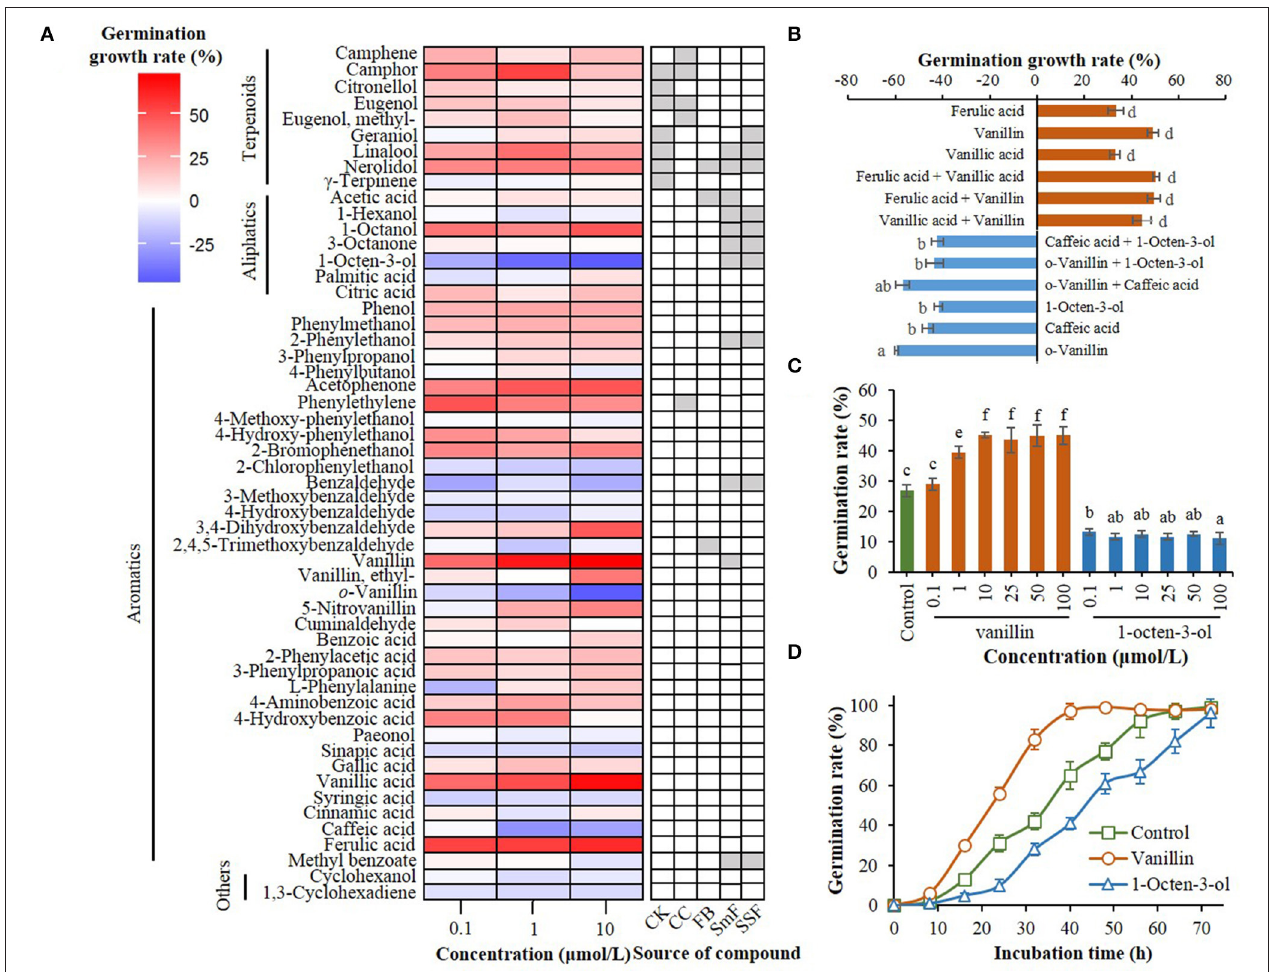
FIGURE 1 | Effect of compounds from C. kanehira , C. camphor , and A. camphorata as well as their analogs on the germination of A. camphorata arthroconidia. (A) Heatmap showing germination growth rate of the arthroconidia after 24h of incubation with candidate compounds in 96-well microplates. CK, Cinnamomum kanehirae ; CC, C. camphora ; FB, fruiting bodies of A. camphorata ; SmF, submerged fermentation of A. camphorata ; SSF, solid-state fermentation of A. camphorata ; (B) Effects of positive and negative regulators (10 µ mol/L) and their synergistic effects on the germination of arthroconidia after 24h of incubation in 500-mL shaking flasks; (C) Germination rate of vanillin- and 1-octen-3-ol-treated arthroconidia after 24h of incubation in 500-mL shaking flasks through concentration scale (0.1–100 µ mol/L). (D) Germination process of the arthroconidia treated with vanillin (25 µ mol/L) or 1-octen-3-ol (25 µ mol/L) in 500-mL shaking flasks. Columns marked with different letters possess values of significantly difference ( P <